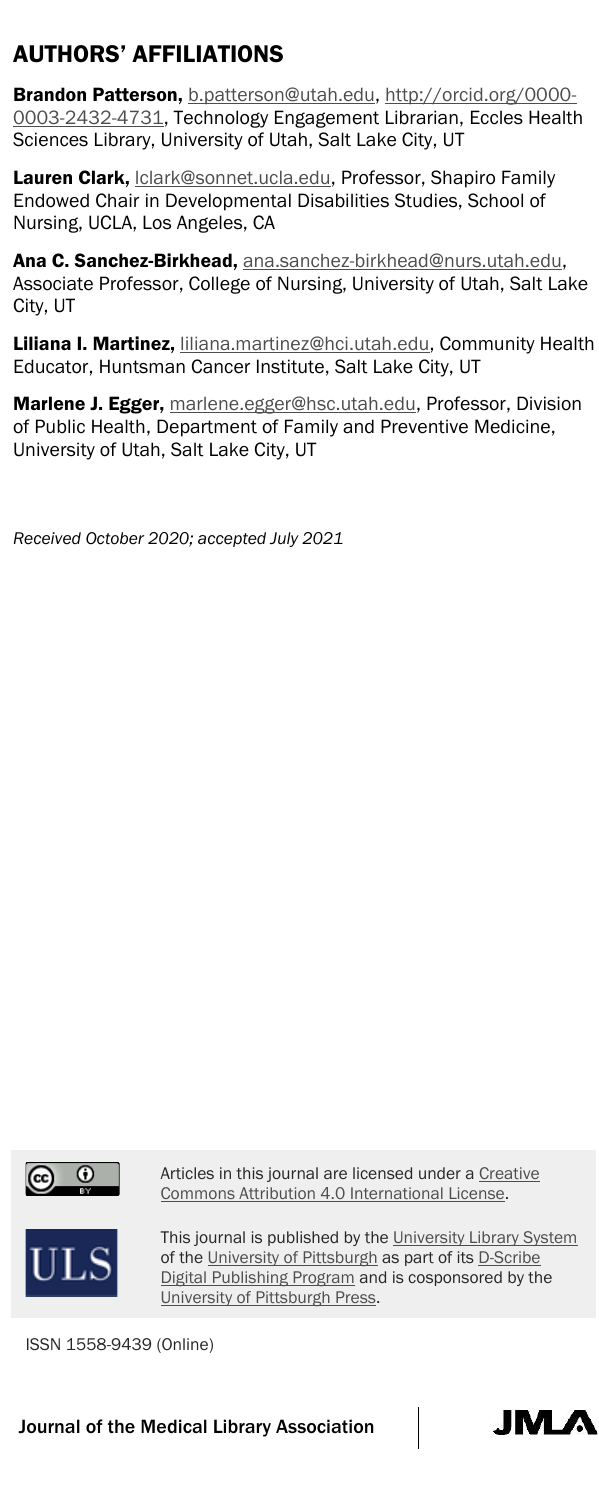
Supplemental Table 1. CRAAP Test and scoring